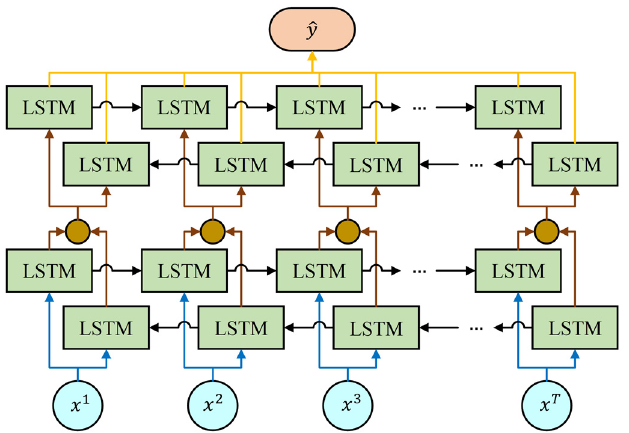
Figure 4. Example of connection between single-layer LSTM network.